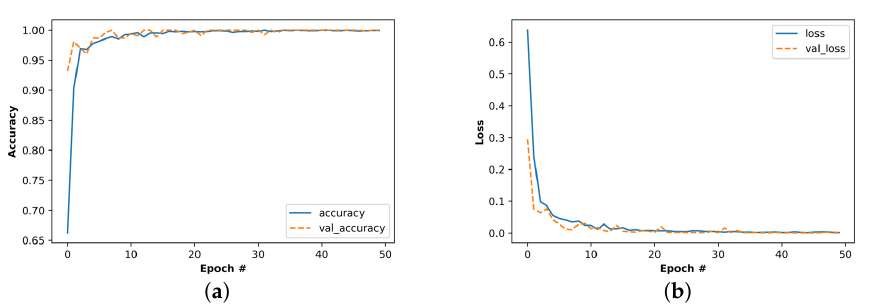
Figure 5. Training performance of the 3 s-segment time–frequency map, ( a ) training and validation accuracies, ( b ) cross entropy